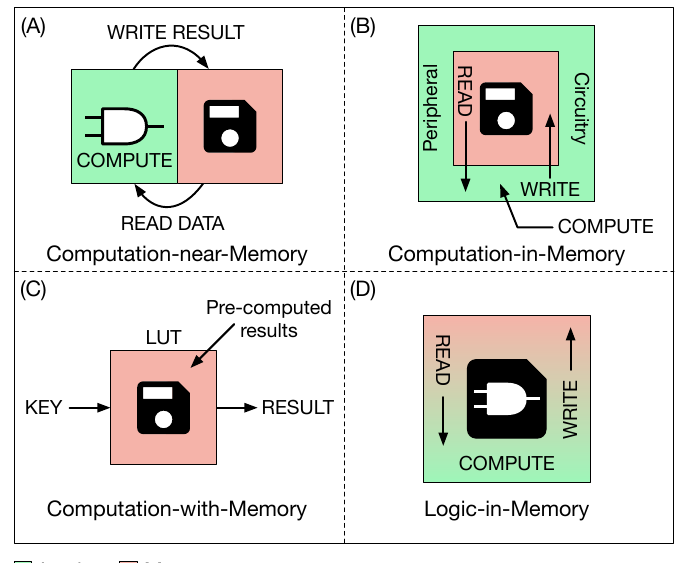
Figure 1. Depending on how the memory is used for computing data, four main in-memory computing approaches can be defined. ( A ) Computation-near-Memory (CnM): 3D-integration technologies allow one to bring computation and storage closer together by reducing the length of the